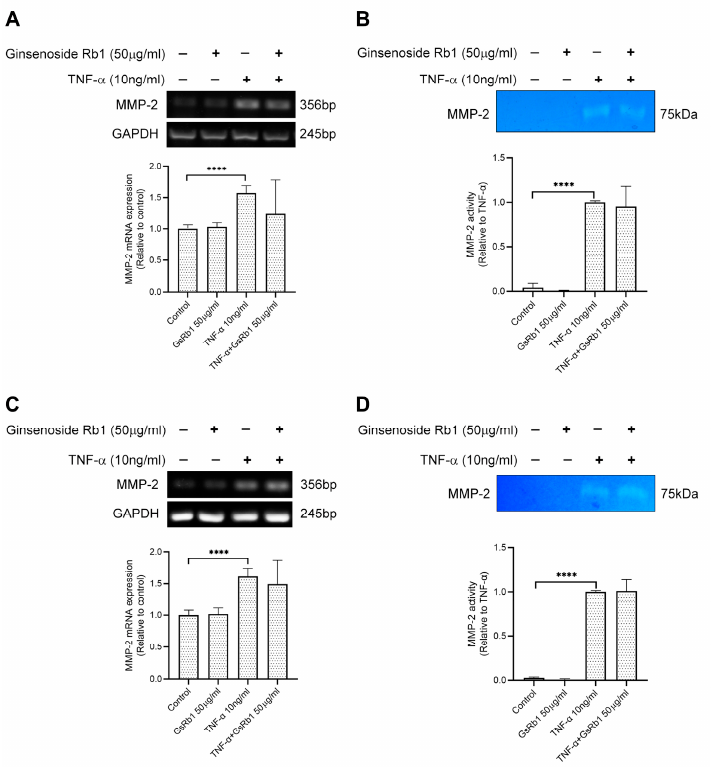
Figure 5. Effects of Ginsenoside Rb1 (GsRb1) on TNF- α -induced MMP-2 gene expression and activity in H9c2 and HepG-2 cells. ( A , B ) H9c2 cells were pretreated with GsRb1 (50 µ g/mL) for 24 h. Then the cells were stimulated by recombinant rat TNF- α (10 ng/mL) for another 24 or 72 h. After the treatment, the cells were collected to examine the gene expression ( A ) and protein activity ( B ) of MMP-2 by RT-PCR and zymography. ( C , D ) HepG-2 cells were pretreated with GsRb1 (50 µ g/mL) for 24 h. Then the cells were stimulated by recombinant rat TNF- α (10 ng/mL) for another 24 or 72 h. After the treatment, the cells were collected to examine the gene expression ( C ) and protein activity ( D ) of MMP-2. Results are shown as mean ± SD from 4 independent experiments. **** p < 0.0001 compared with control or TNF- α only.